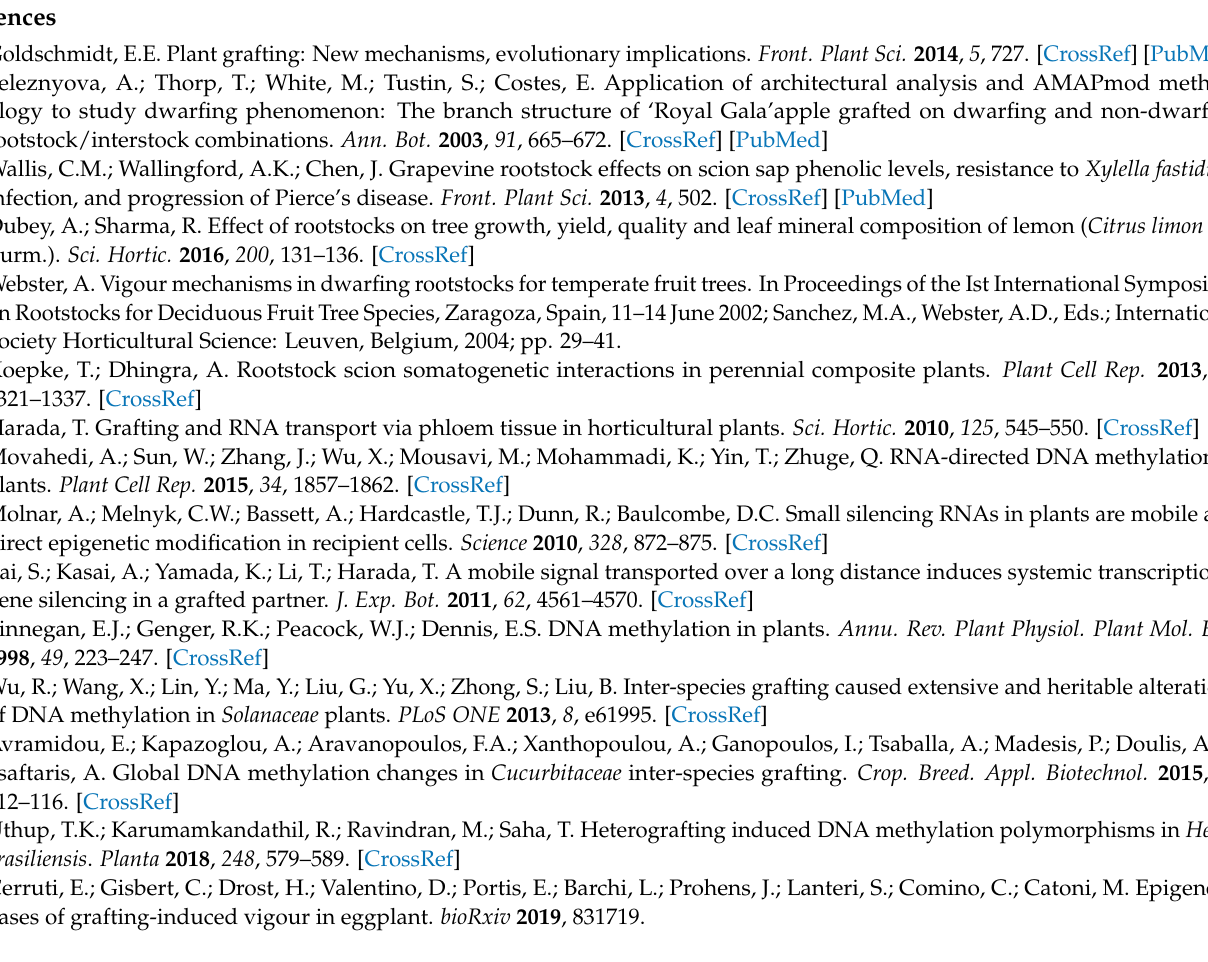
contexts, Figure S7: KEGG enrichment analysis of DMGs in CG and CHG contexts, Table S1: Statistics of methylated cytosines, Table S2: DMRs and DMGs, Table S3: GO enrichment analysis of DMGs, Table S4: The DMGs in CHH context potentially related with hormone